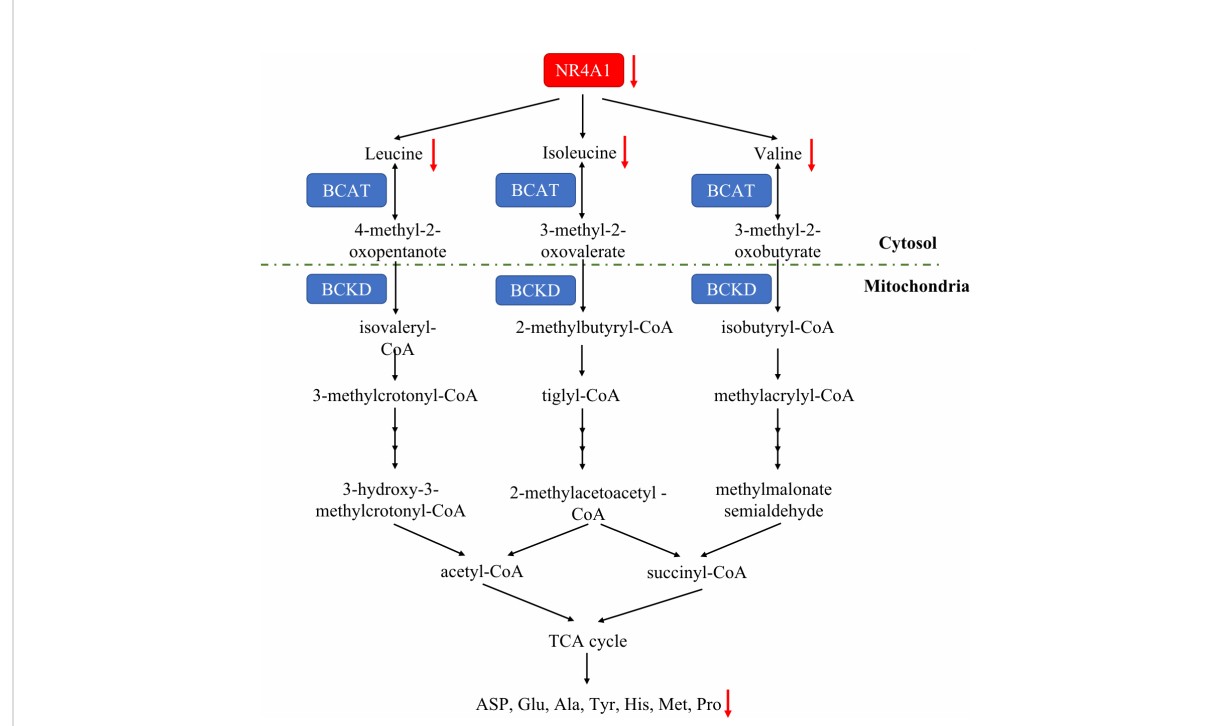
FIGURE 6 The amino acid metabolic pathway of NR4A1. In zebra fi sh larva, NR4A1 de fi ciency can decrease key branched-chain amino acids Val, Leu, and Ile, leading to the inhibition of ASP, Glu, Ala, Tyr, His, Met and Pro.